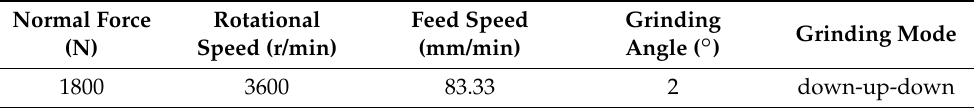
Table 1. The experimental parameters.